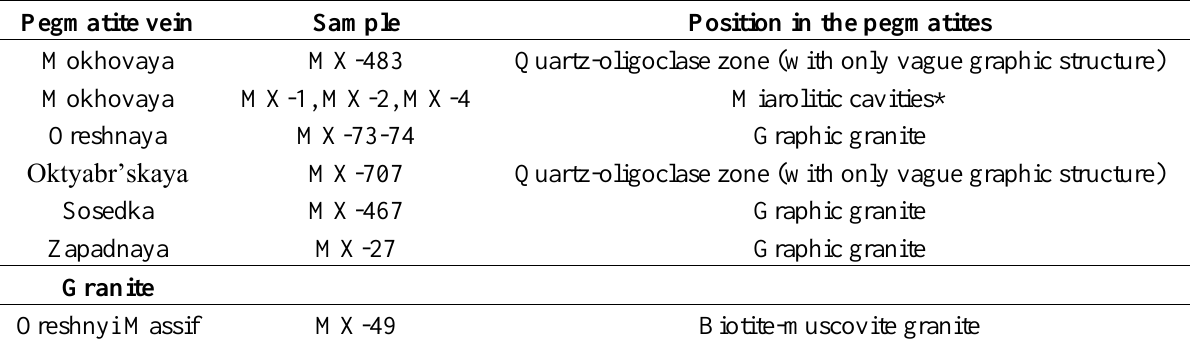
Table 1. Origin of the pegmatite quartz samples from the Malkhan pegmatite field in Transbaikalia,